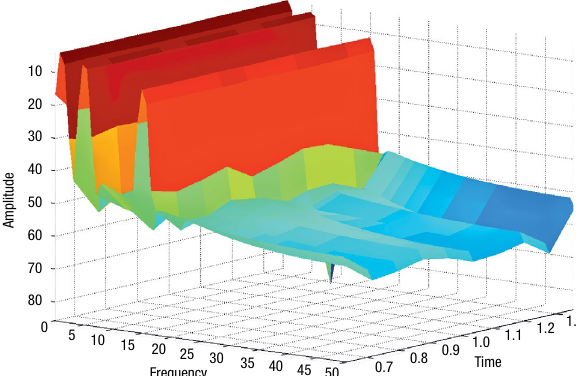
Fig. 17. Sum of 3 sinuses (a), Signal Processing